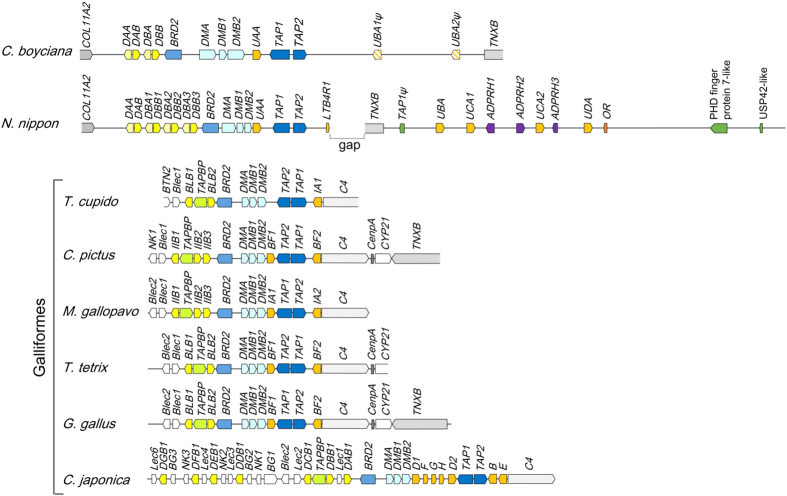
Comparative genomic map of the MHC regions in various avian species.Genomic structures of the MHC regions in Ciconia boyciana, Nipponia nippon11, and the six Galliformes (Gallus gallus5, Coturnix coturnix japonica6, Meleagris gallopavo7, Chrysolophus pictus8, Tetrao tetrix9, and Tympanuchus cupido10) were compared. In Nipponia nippon, the orientation of the fragment containing the MHC-I cluster and TNXB remains unknown because of a gap downstream of TAP2.